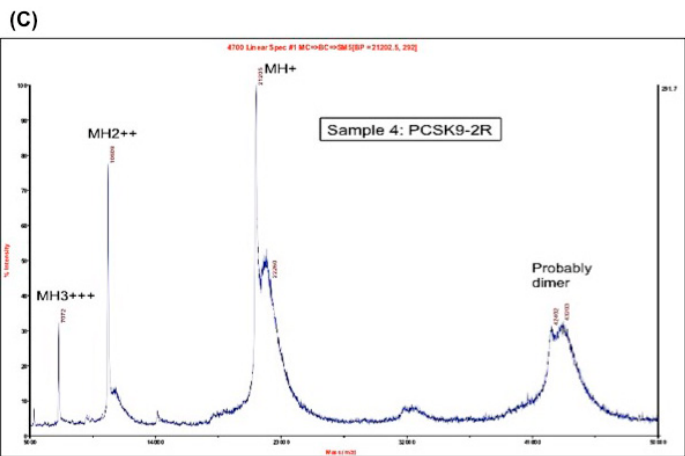
Figure 1. ( A ) Coomassie blue staining of the purified region-1 and region-2 of mPCSK9 proteins. Region-1 (residues 152–351) and region-2 (residues 249–452) of mouse catalytic domain were cloned and expressed by pET-3a plasmids. The proteins were reduced and purified by a reverse-phase high-performance liquid chromatography (HPLC) on an Agilent 1100 HPLC system. The purified proteins were analyzed by SDS/PAGE and stained with Coomassie blue. The positions of expressed proteins are shown; ( B ) MALDI mass spectrometry on Region-1. The molecular mass of purified PCSK9 region-1 in fully reduced form (PCSK9-1R). The molecular mass of PCSK9 region-1 as determined by MALDI was 21,201 Da; ( C ) MALDI mass spectrometry on Region-2. The molecular mass of purified PCSK9 region-2 in fully reduced form (PCSK9-2R). The molecular mass of PCSK9 region-2 as determined by MALDI was 21,355 Da.